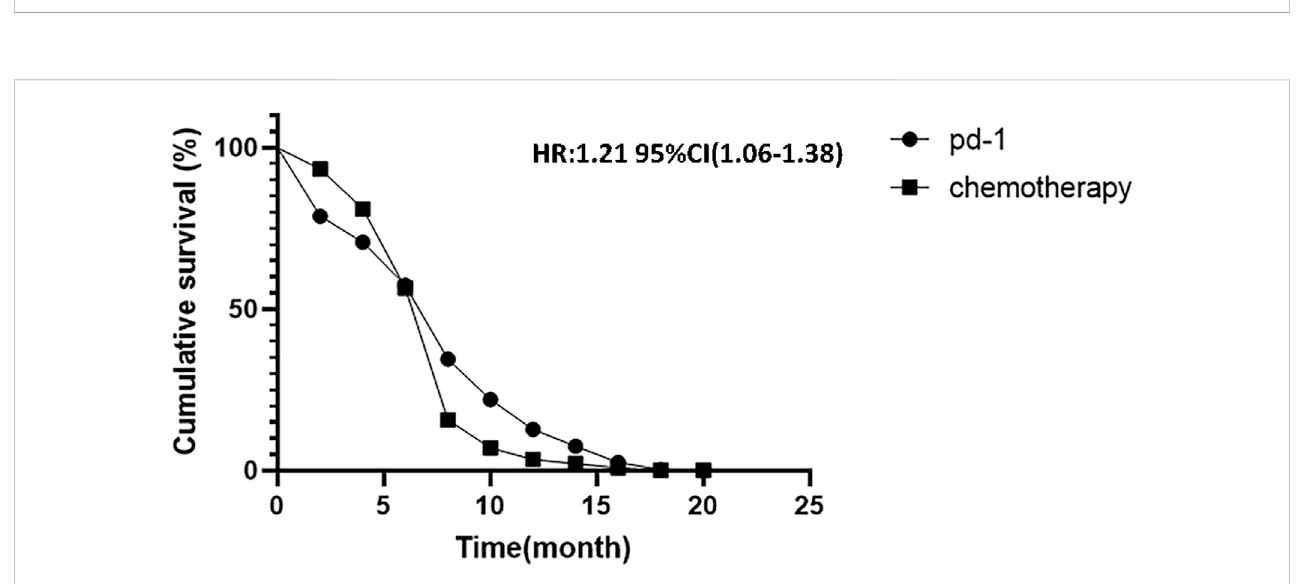
FIGURE 8 Kaplan-Meier analysis of cumulative progression-free survival between PD-1 inhibitors and chemotherapy.